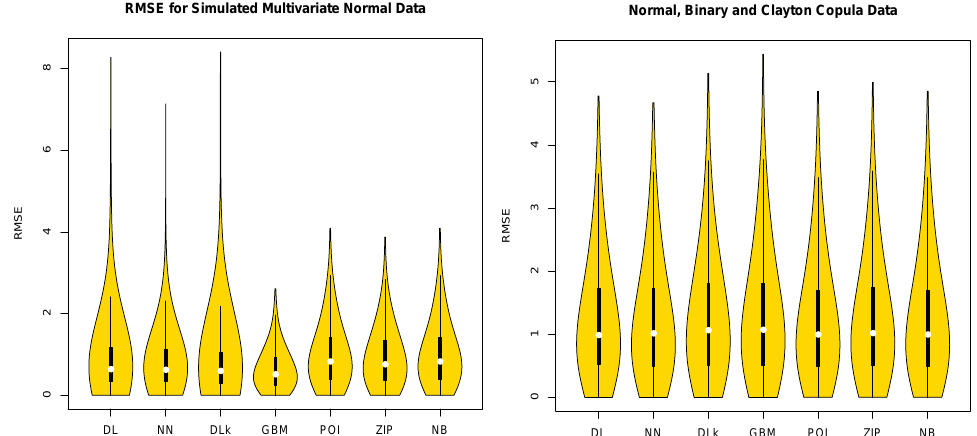
Figure 2. Violin Plots of RMSE with Simulated Multivariate Normal Data and Non-Normal Combined Data with Multivariate Normal, Copula and Binary